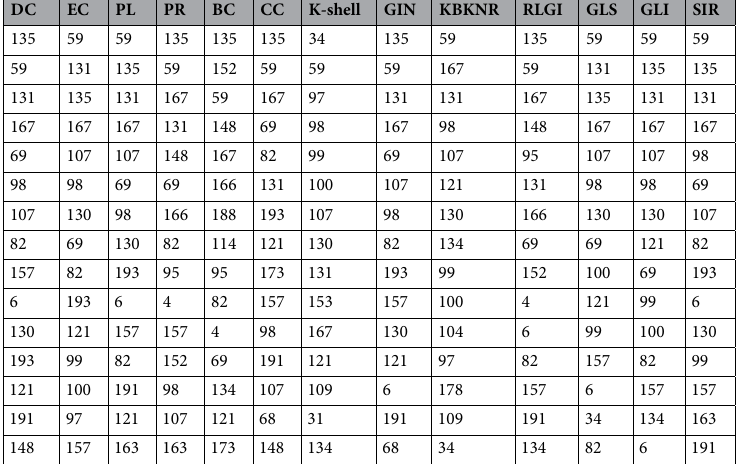
Table 8. Top-15 nodes in the Jazz network obtained by different algorithms.